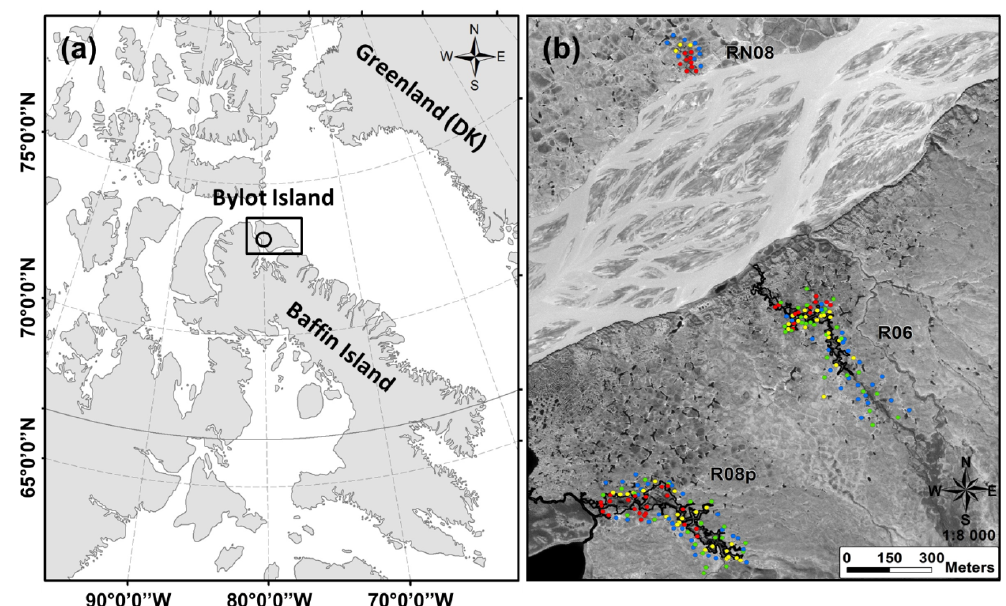
Figure 1. Location of the study area. (a) The Qarlikturvik valley (black circle), Bylot Island (black rectangle), Nunavut. (b) The 197 sampling sites located along the three selected gullies (wet polygons ( n = 62): blue circles; <5-year disturbed polygons ( n = 44): yellow circles; >5- year disturbed polygons ( n = 43): red circles; mesic environments ( n = 48): green